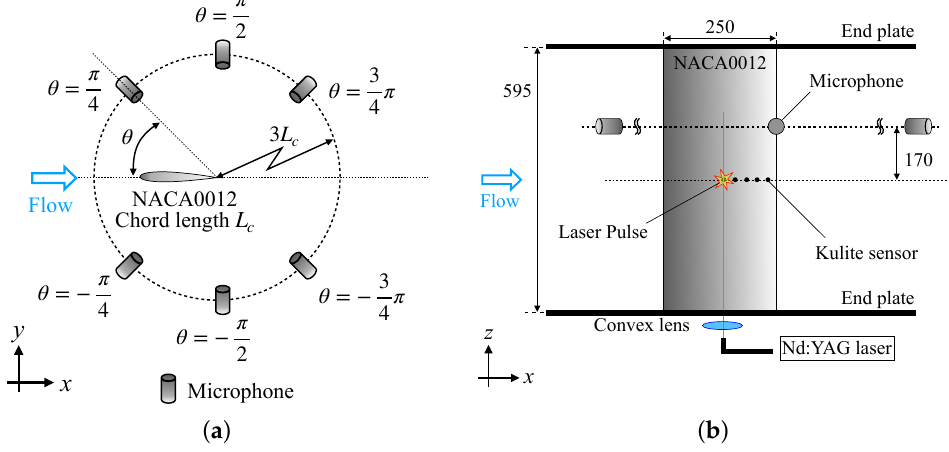
Figure 2. Experiment setup. ( a ) Side view; ( b ) Bottom view (dimensions in